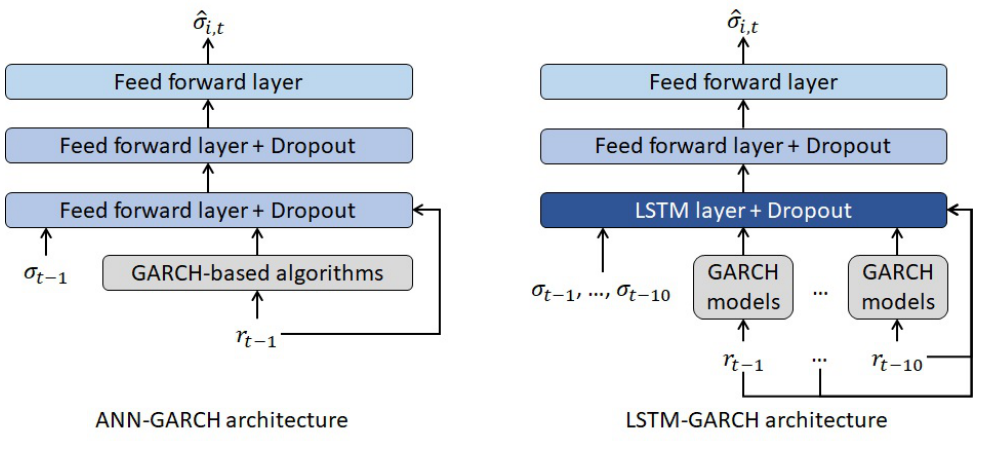
Figure 2. ANN-GARCH and LSTM-GARCH